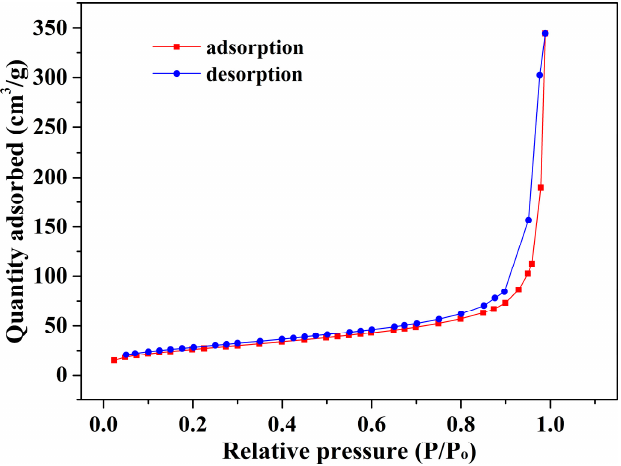
Figure 4. N 2 adsorption-desorption isotherm of the Alg-EDTA.